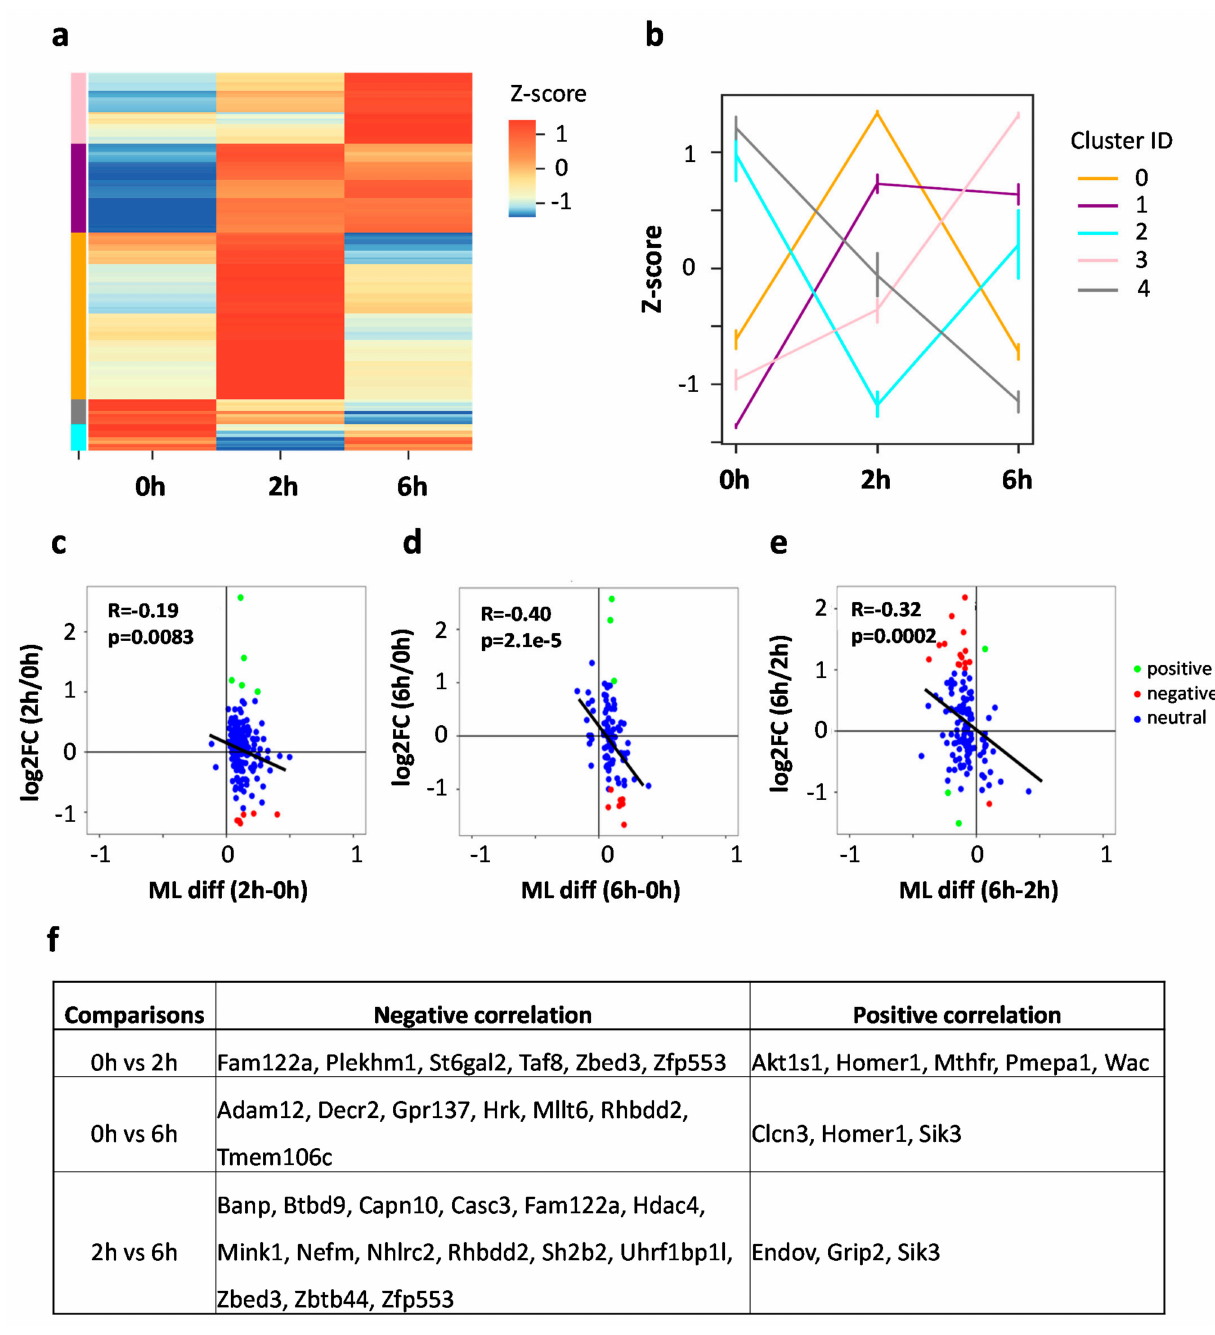
Figure 6. Correlation of RNA m 5 C methylation with RNA expression. ( a ) Clustering of the differentially methylated m 5 C sites (DMS) using Z-score normalization. The DMS sites were grouped into five clusters. ( b ) Line plot showing the average methylation level for each cluster. ( c – e ) Dot plots showing the pair-wise Pearson correlation between gene expression and mRNA methylation: 0 h vs. 2 h ( c ), 0 h vs. 6 h ( d ), and 2 h vs. 6 h ( e ). ( f ) A summary table showing the transcripts with negative/positive correlations between m 5 C methylation and mRNA expression among the three